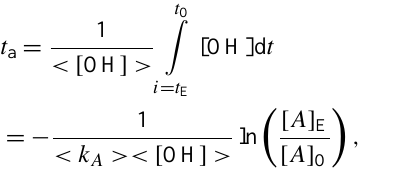
Table 1. Contribution of CO from geographical sources averaged over all BORTAS-B flights, lumping all other contributions < 2 ppb into “Other”. Background refers to any residual CO before the beginning of the BORTAS-B period.